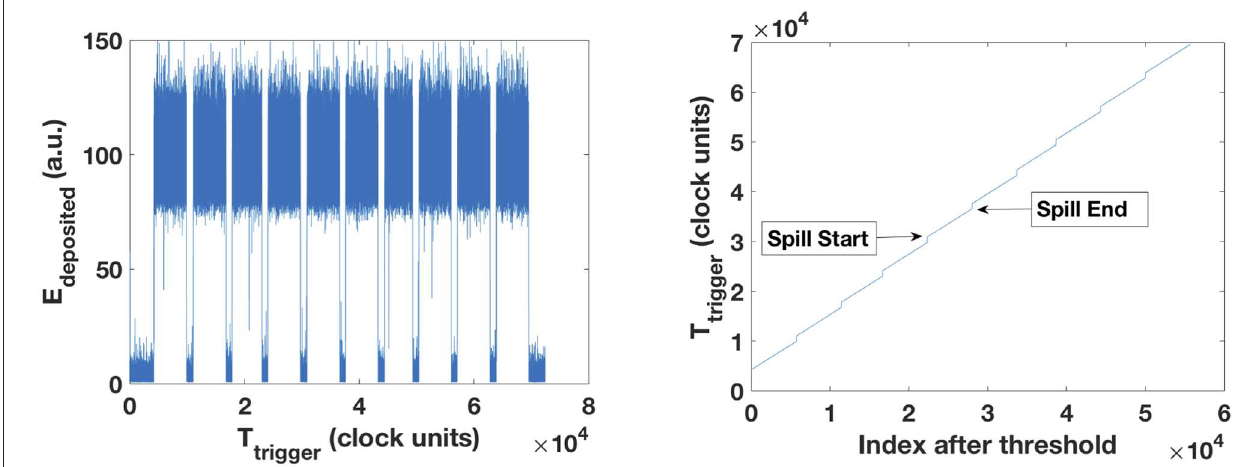
FIGURE 2 | (Left) Energy deposited in the trigger detector along the acquisition time. The relative acquisition is given by the internal clock of the FADC unit. (Right) After setting a threshold at 60 (a.u.), we obtain the index of the spill start and the spill end and the corresponding trigger time given by the FADC unit. The time difference between those times gives the time between